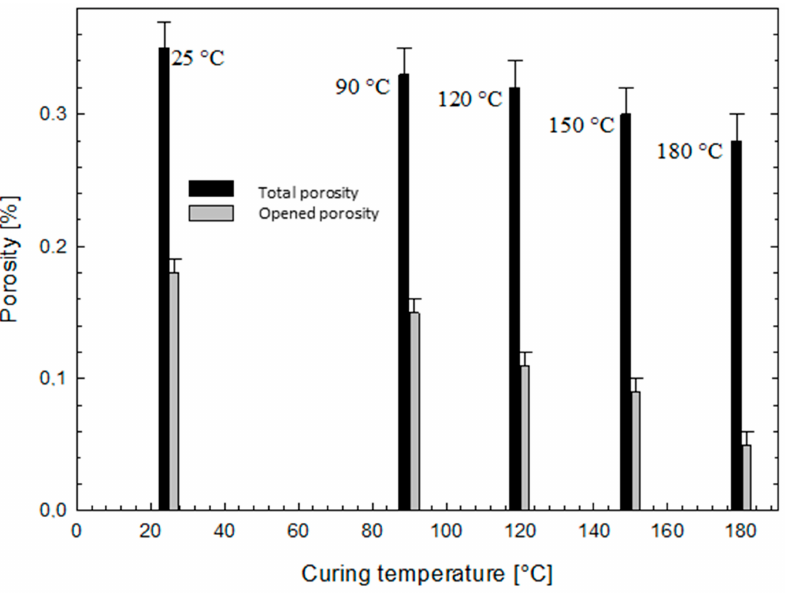
Figure 4. Total and opened porosity of coatings with error bars deposited on structural steel and cured at di ff erent temperatures. The withdrawal rate was 2.3 mm/s.